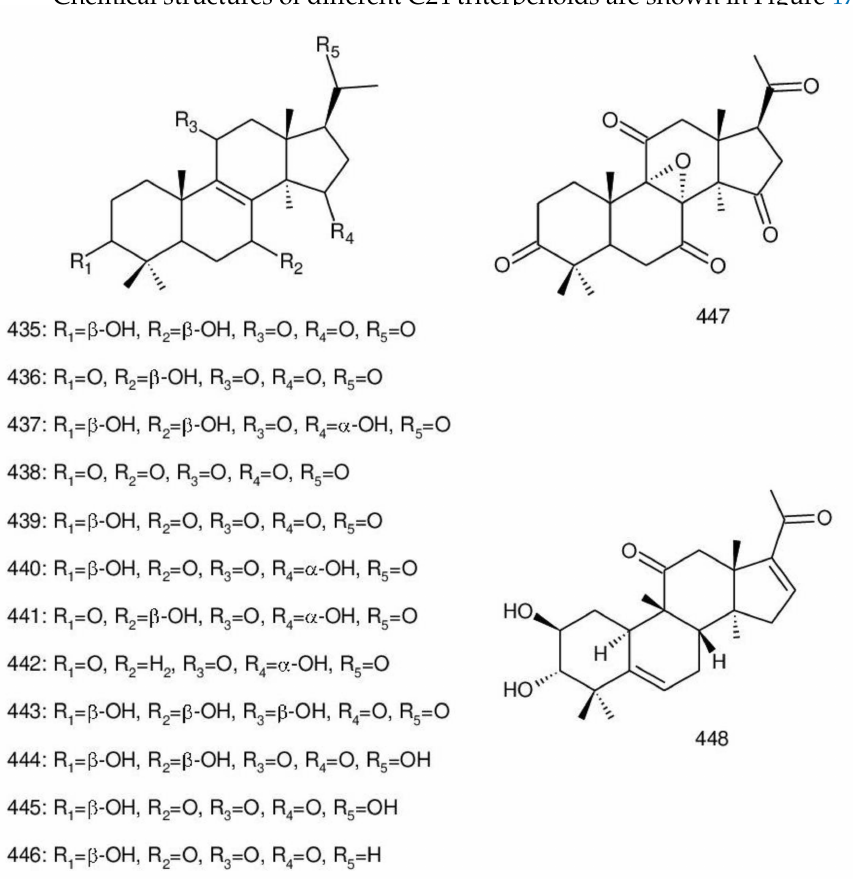
Figure 17. Chemical structures of several C24 triterpenoids ( 435 – 448